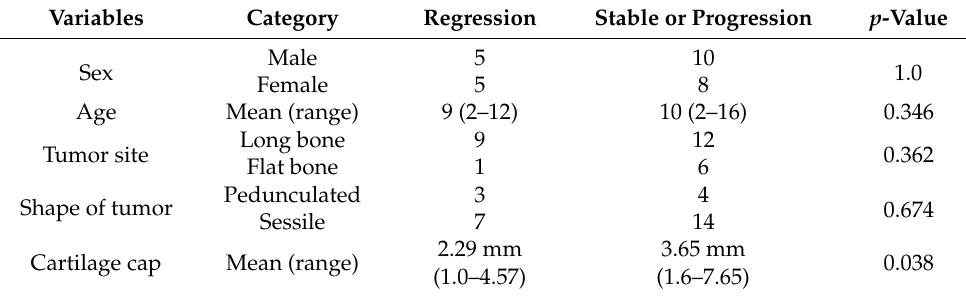
Table 3. The variables for predicting tumor